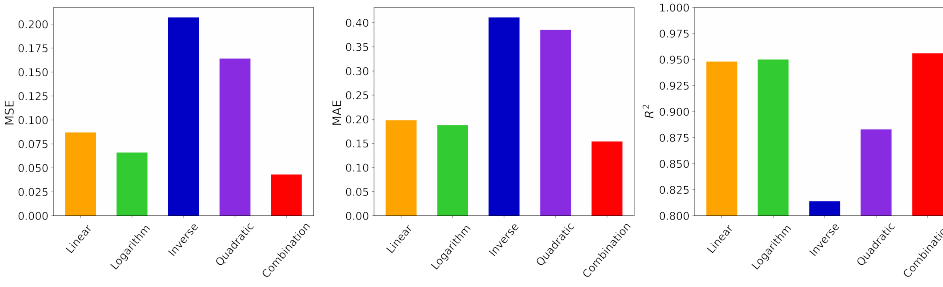
Figure 3. Comparison of the optimal case effects of various